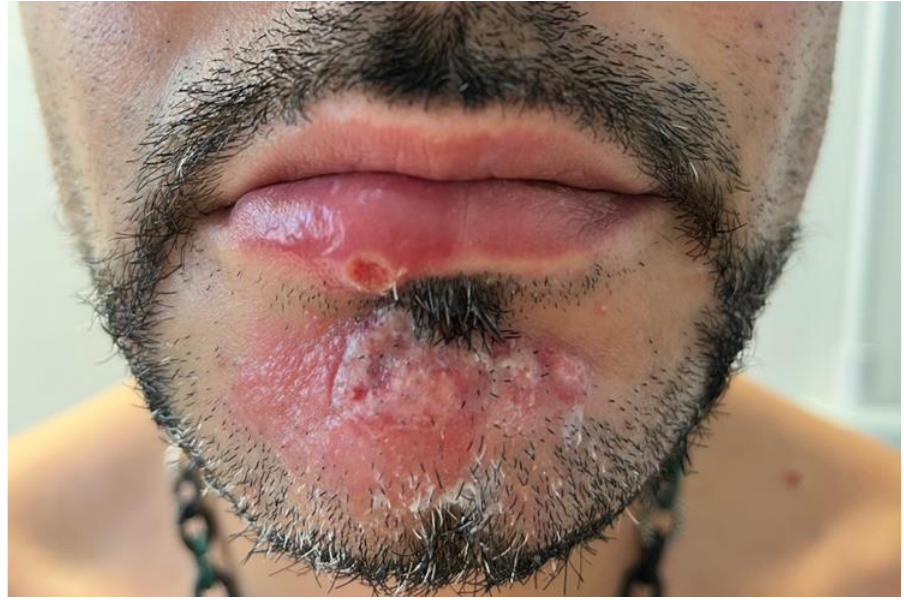
Figure 1. The clinical picture of patient 1: note an erythematous plaque covered in vesicles on the chin, an oval ulcer on the lower lip with a white peripheral border, and a central erosive area.